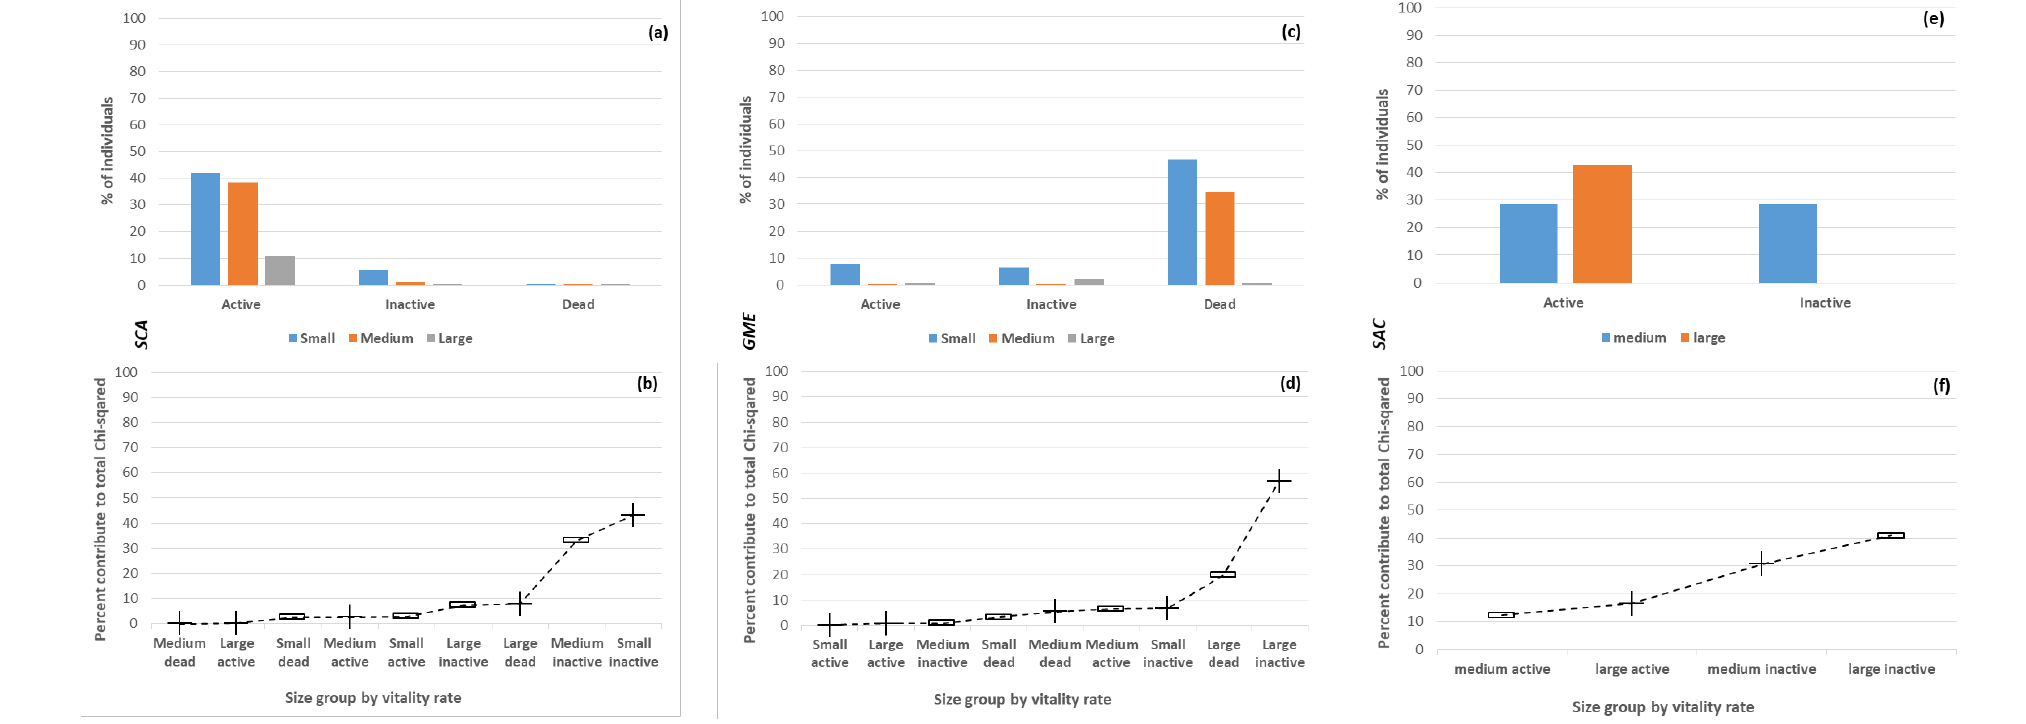
Figure 3. The observed percentage of the number of individuals by the vitality rate across size intervals (upper graph) and the increasing order of the percent contribution of groups to total within-species variation with respect to expected values (lower graph) observed in Scyliorhinus canicula ( SCA , ( a , b )), Galeus melastomus ( GME , ( c , d )), and Squalus acanthias ( SAC , ( e , f )) after trawl catch during a fishery-independent trawl survey in the Asinara Gulf during June – October 2022. Plus and minus labels on the data indicate observed values higher and lower than expected, respectively.